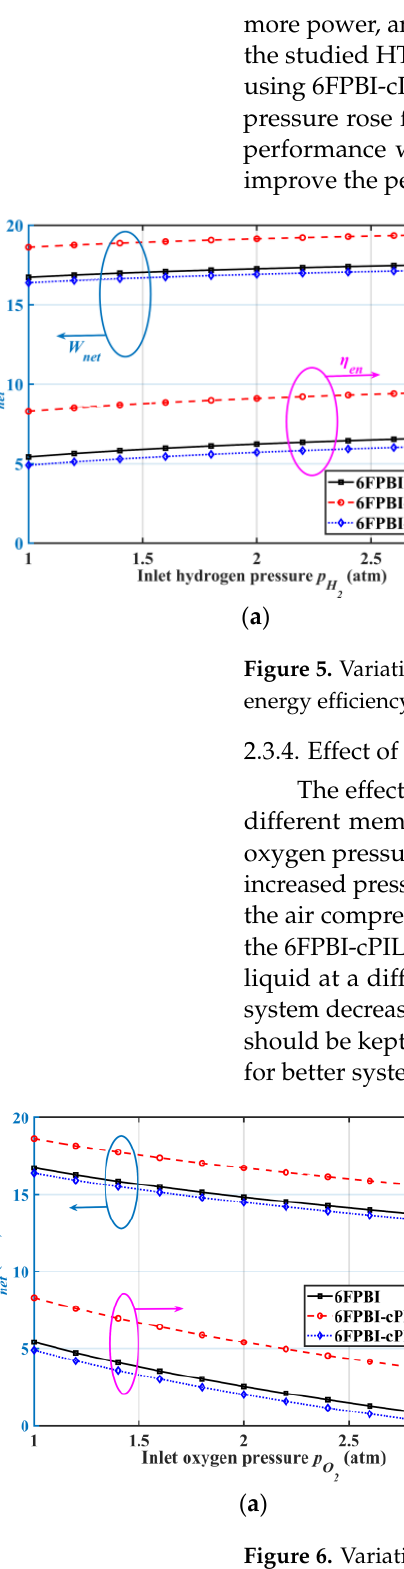
( b ) Figure 4. Variation of system performance with inlet temperature: ( a ) output power 𝑊 𝑛𝑒𝑡 and en- ergy efficiency 𝜂 𝑒𝑛 ; ( b ) the coefficient of performance 𝐶𝑂𝑃 .